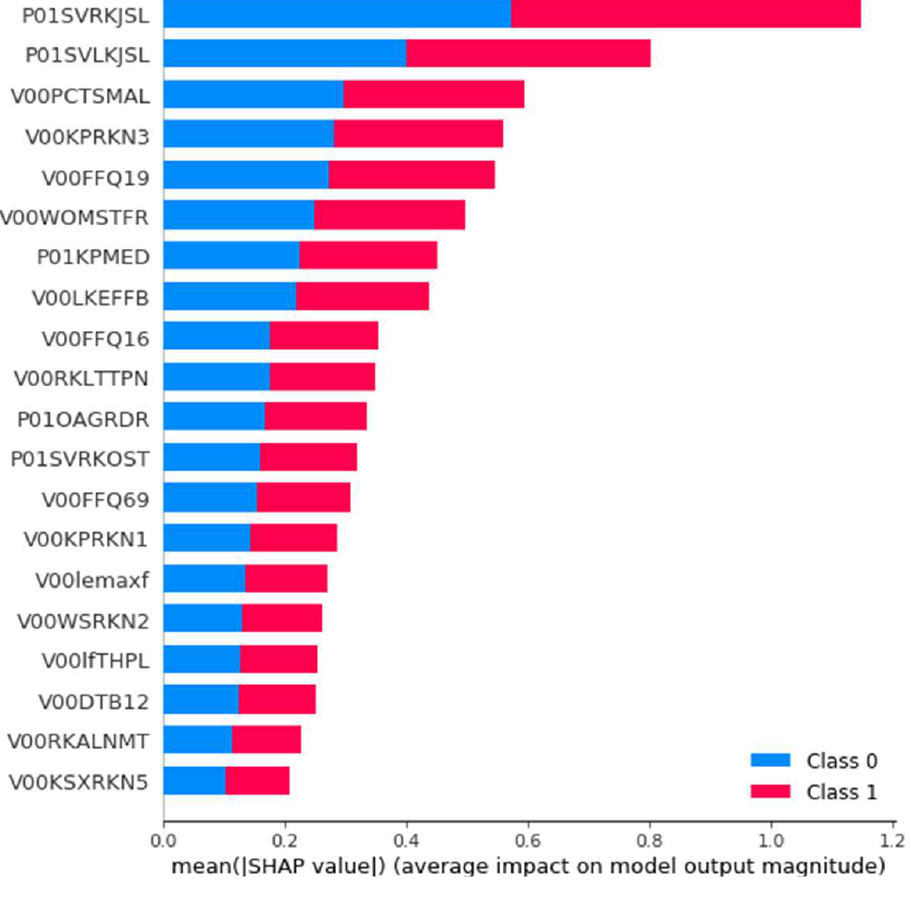
Figure 13. The average impact magnitude of 29 features on the LR model output for the OAI dataset for all